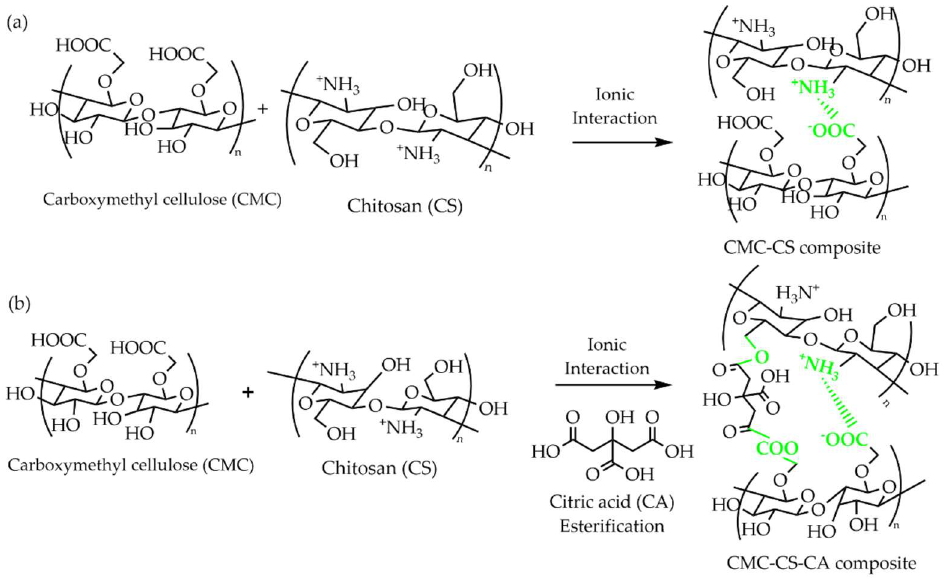
Figure 1. Proposed reaction for the formation of the ( a ) CMC – CS and ( b ) CMC-CS-CA hydrogels.